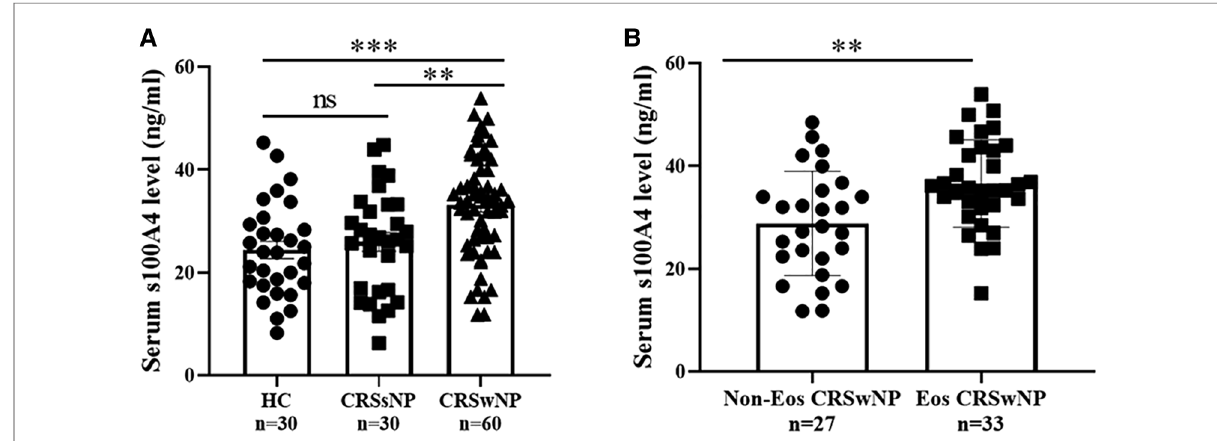
FIGURE 1 Comparison of serum S100A4 expression among three groups. ( A ) Serum S100A4 levels were increased in the CRSwNP group than the CRSsNP and HC groups. ( B ) Compared to non-EOS CRSwNP, serum S100A4 levels were elevated in the EOS CRSwNP. ** p <0.01, *** p <0.001, ns, no signi fi cance. Abbreviations: CRSwNP, chronic rhinosinusitis with nasal polyps; CRSsNP, chronic rhinosinusitis without nasal polyps; HC, healthy control; EOS CRSwNP, eosinophil chronic rhinosinusitis with nasal